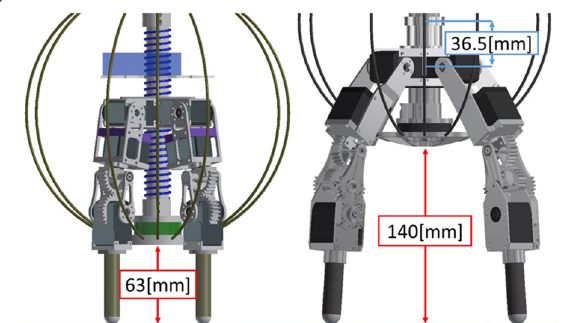
Fig. 4 Comparison of the lower half of the space; Left is QRoSS I and Right is QRoSS V